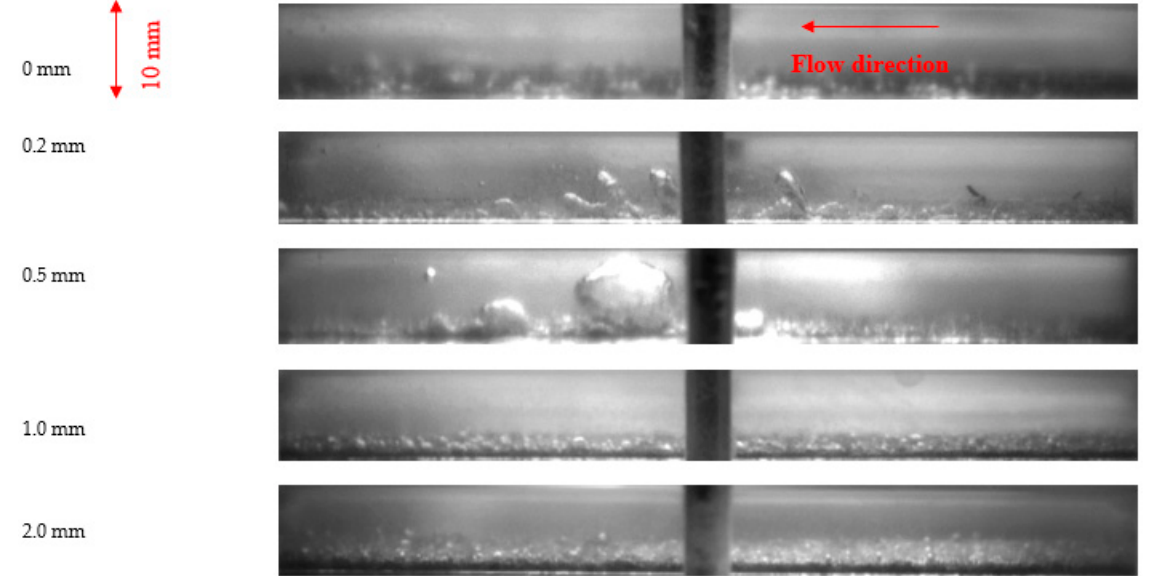
Figure 9. Flow and bubble formation pattern at the maximum heat flux for all the porous thickness: ∆ T sub = 70 K; G = 400 kg · m − 2 · s − 1 .